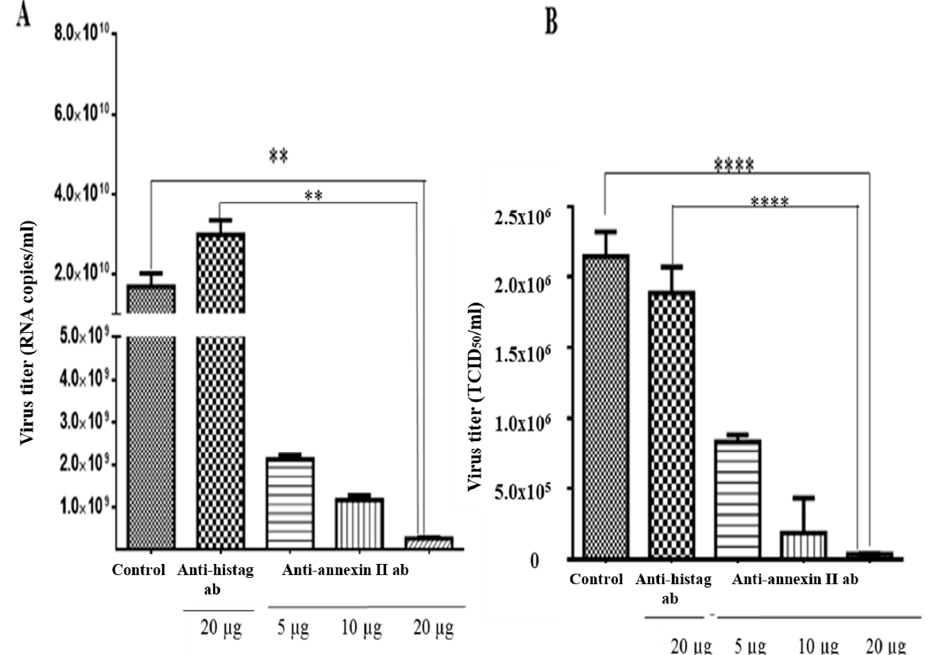
Figure 4. Antibody-mediated DENV2 infection inhibition assay. Vero cells were either treated with various concentrations of rabbit polyclonal anti-annexin II antibody, 20 µ g of rabbit polyclonal anti-histag antibody or no antibody (control), for 1 h, prior to DENV2 adsorption. Infections were allowed for 30 h. ( A ) Intracellular DENV2 titer was quantified with Liferiver DENV general-type real time RT-PCR Kit. ( B ) Extracellular DENV2 titer was determined by TCID 50 . The experiment was independently repeated in triplicates. Statistically significant reduction in virus infection and output were observed in the anti-annexin-II-treated Vero cells, compared to the control-antibody-treated and no-antibody-treated Vero cells (** indicates p < 0.01, **** indicates p < 0.0001), as determined by one-way ANOVA analysis; ab—antibody.